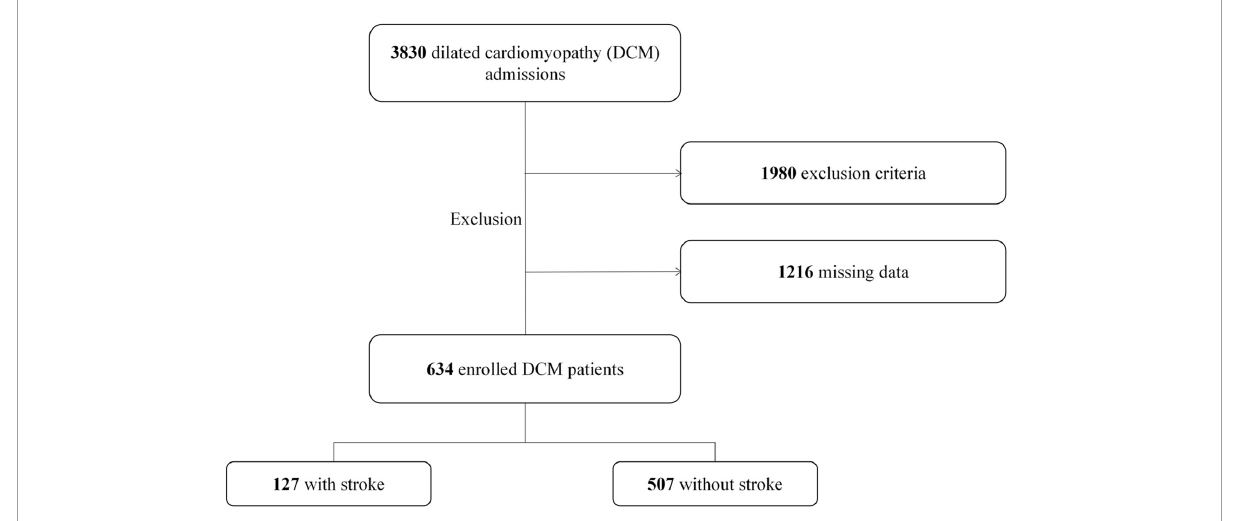
FIGURE1 Flowchart describing the screening of patients with dilated cardiomyopathy